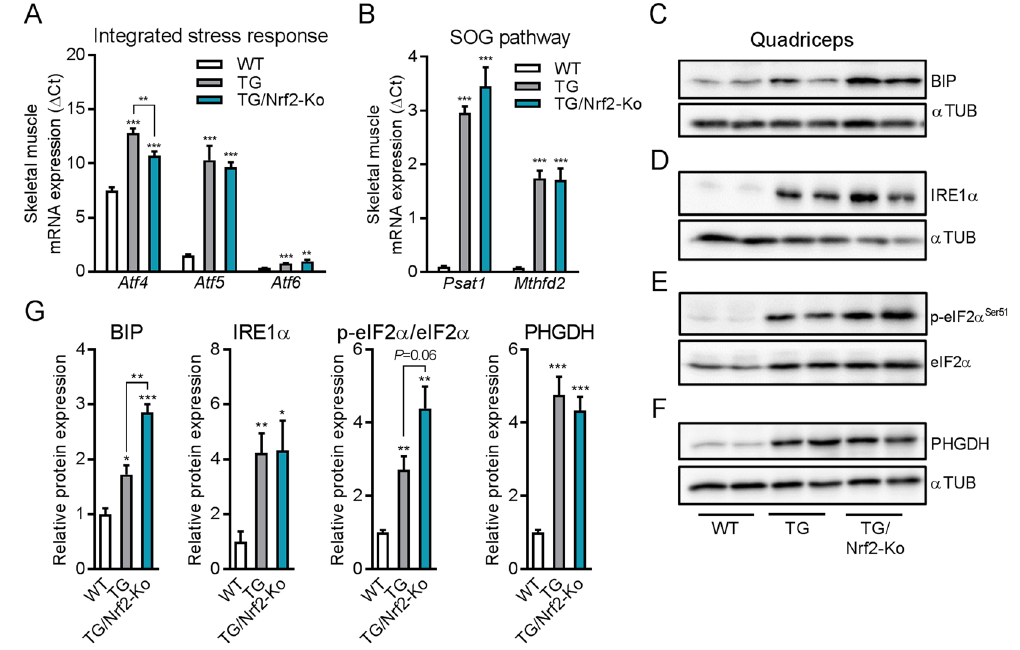
Figure 4. Skeletal muscle expression profile of ER-stress and integrated stress response. ( A ) Skeletal muscle mRNA expression in quadriceps muscle integrated mitochondrial stress response (ISRmt) transcription factors and ( B ) genes of the serine, one-carbon cycle, and glycine synthesis (SOG) pathway (n = 8–10). ( C – F ) Representative immunoblots of BIP, IRE1 α , and PHGDH from cropped gels using α Tubulin ( α TUB) as loading control and phospho-eif2 α Ser51 and total eif2 α of one uncropped gel in quadriceps muscle from 24 wks old mice (2 samples shown out of 4–5 analyzed per group). ( G ) Quantification of integrated stress response (ISR) and SOG proteins in quadriceps muscle from 24 wks old mice (4–5 per group). Relative or normalized data are expressed as means + SEM; * p < 0.05; ** p < 0.01; *** p <